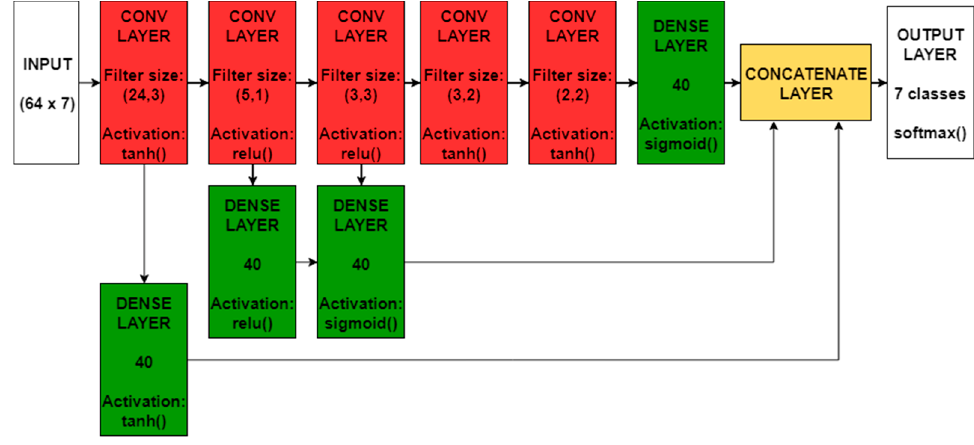
Figure 6. Deep architecture for real-time TMR.